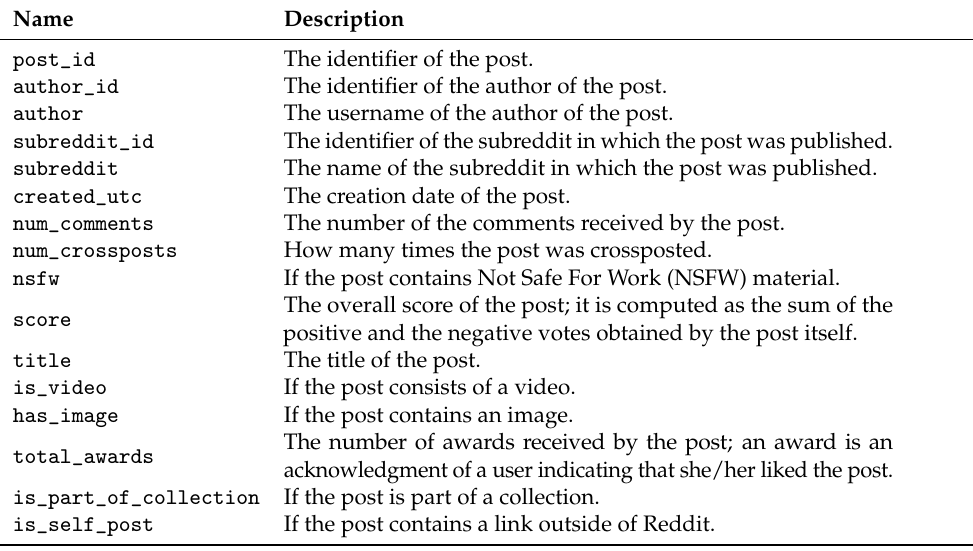
Table 1. The fields extracted for each post.